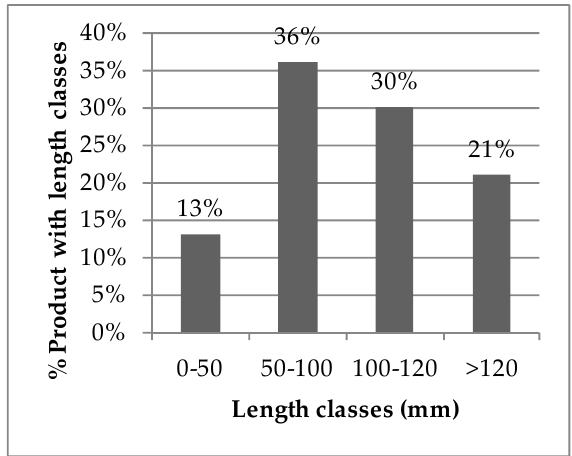
Figure 3. Particle size distribution of chipped material.